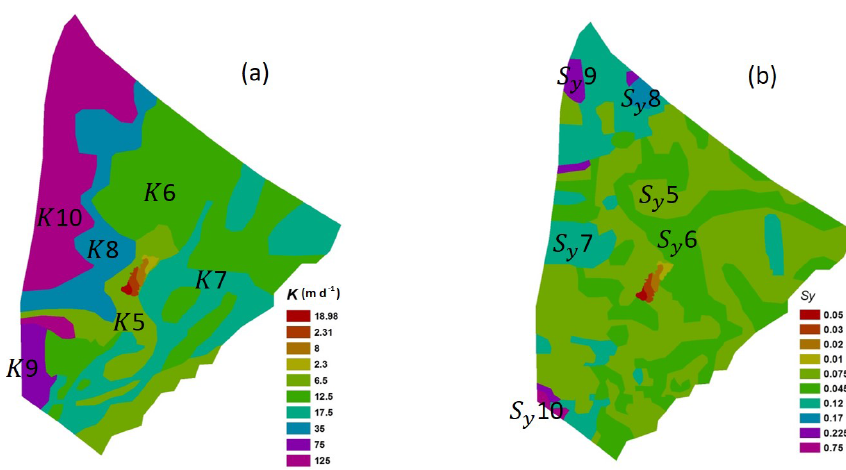
Figure 7. Parameter distributions map for the NCP (modified based on figures in the literature; Liu et al.,